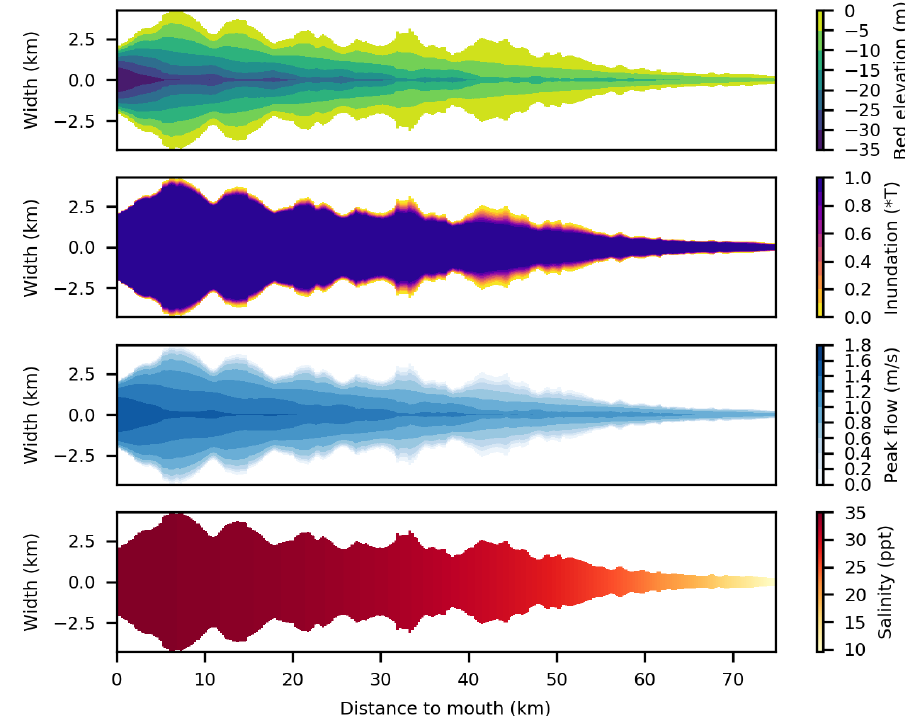
Figure 5. Resulting predictions of bed elevation with respect to the high water level, inundation duration, peak flow velocity and salinity for the Western Scheldt.